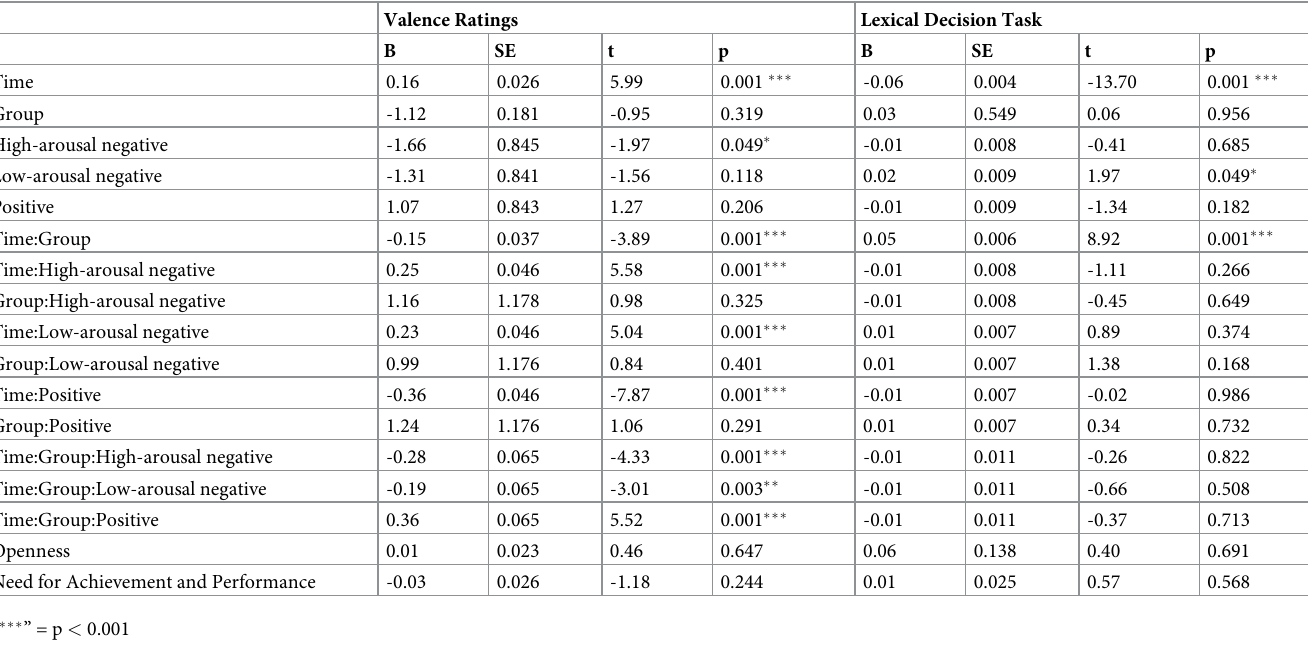
Table 2. Estimates of the regression coefficients, their standard errors, t-values and p-values for the valence and the LDT experiments in the overall